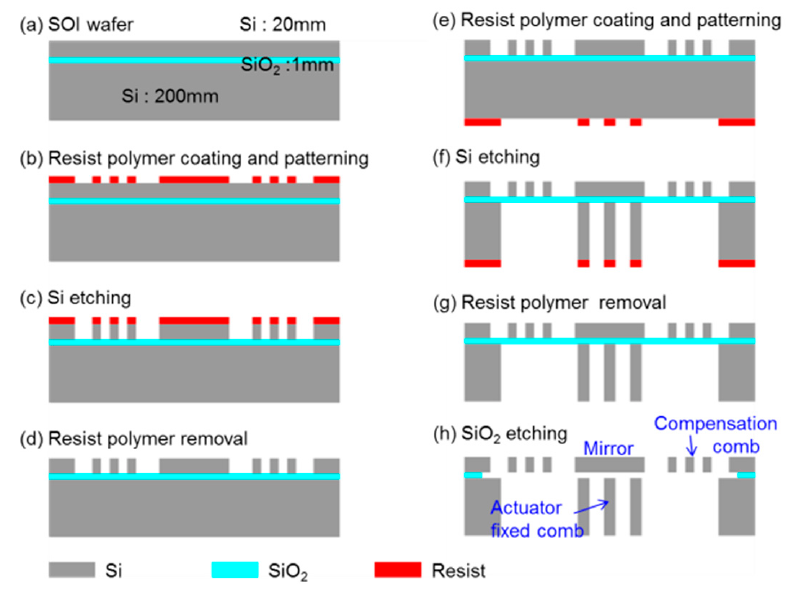
Figure 6. Schematic diagram of the fabrication processes.